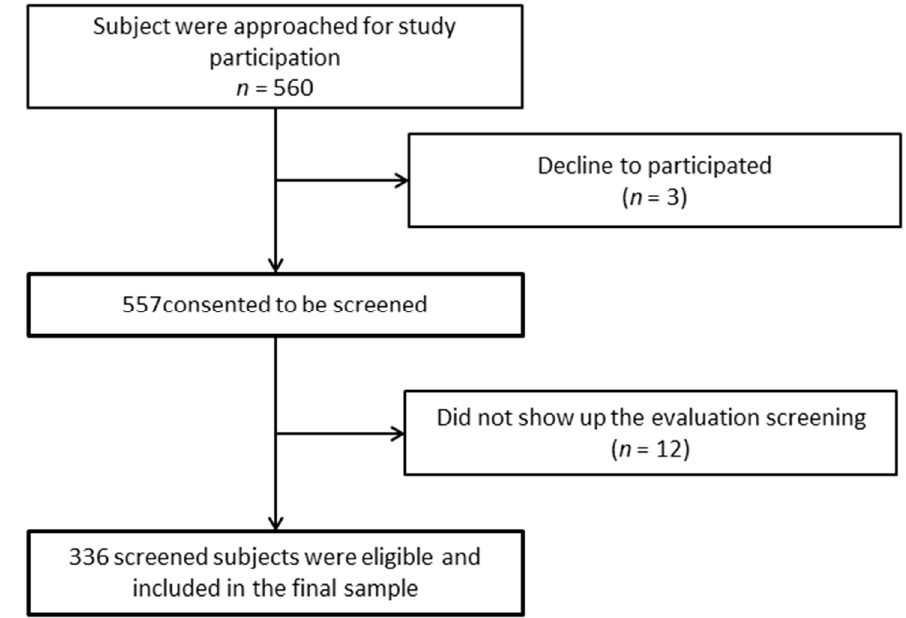
Figure 1. Flow diagram of study design.